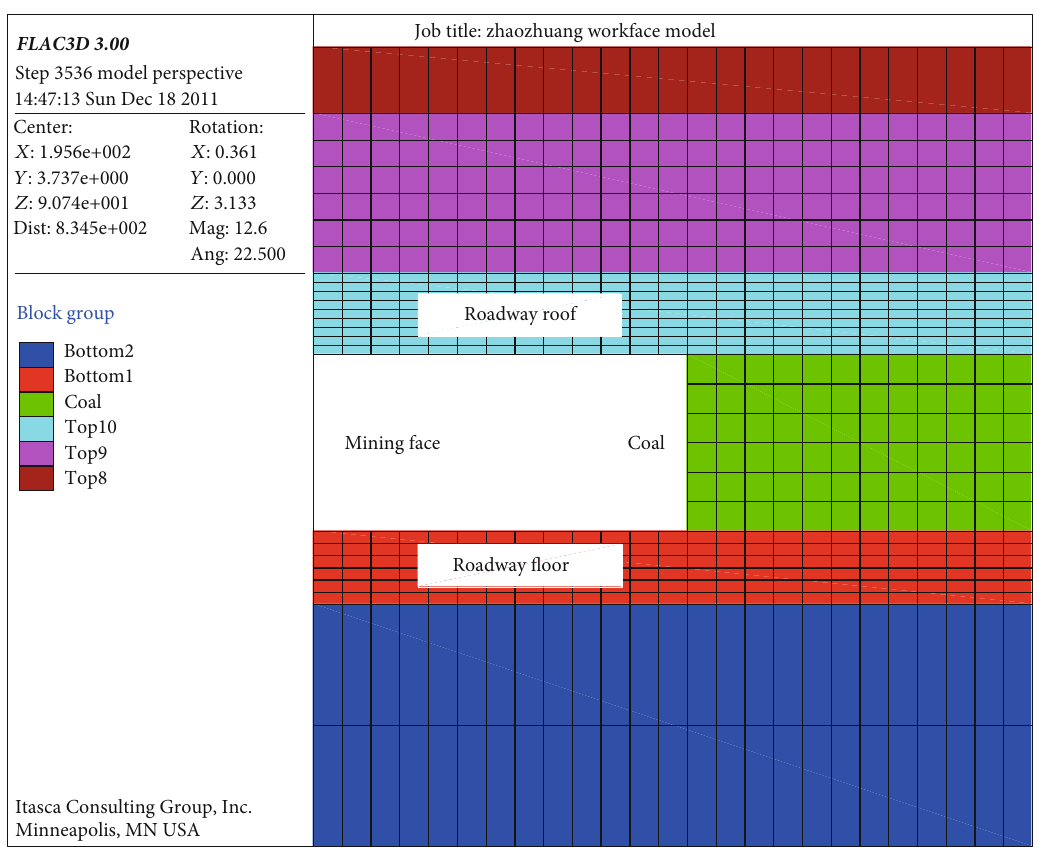
Figure 3: Numerical model Table 2: Coal parameters.